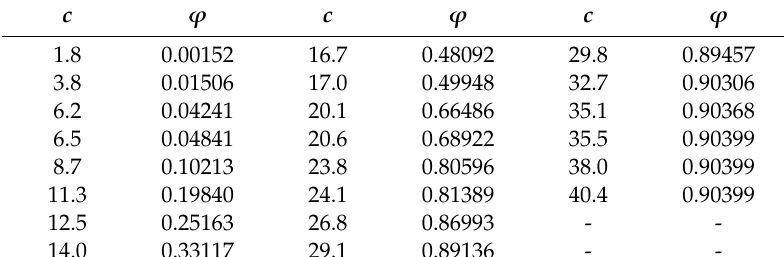
Table 13. Corresponding 𝜑 for c in Table 12.